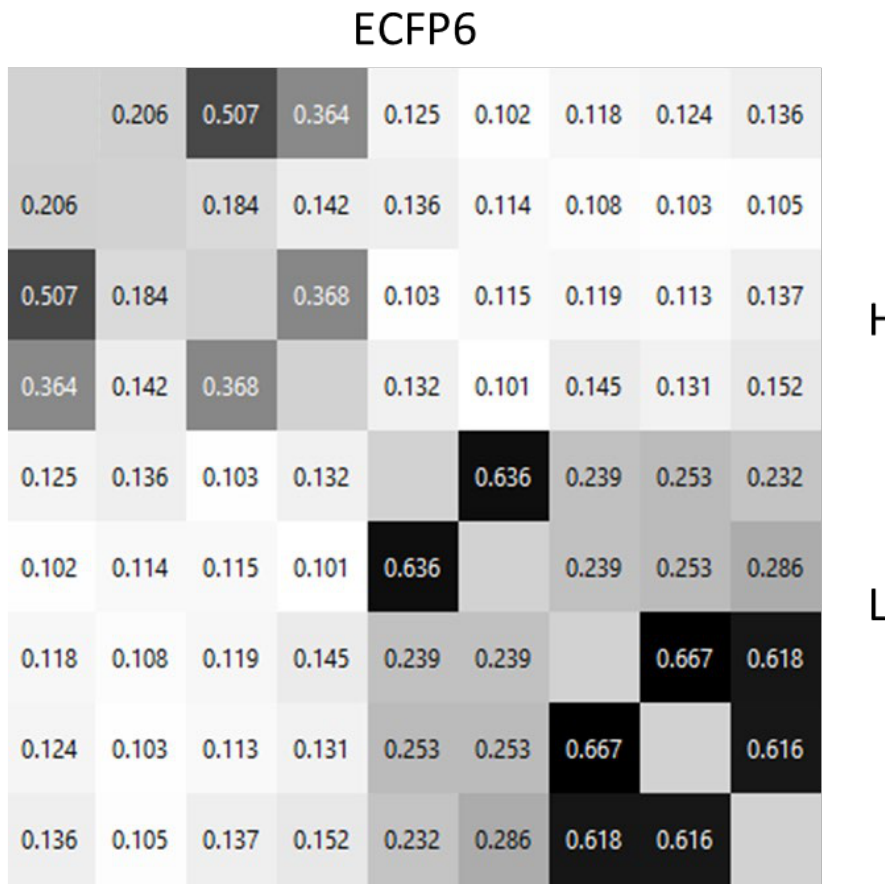
Figure 1. Similarity matrix calculated with ECFP 6 for molecules 1 – 9 .